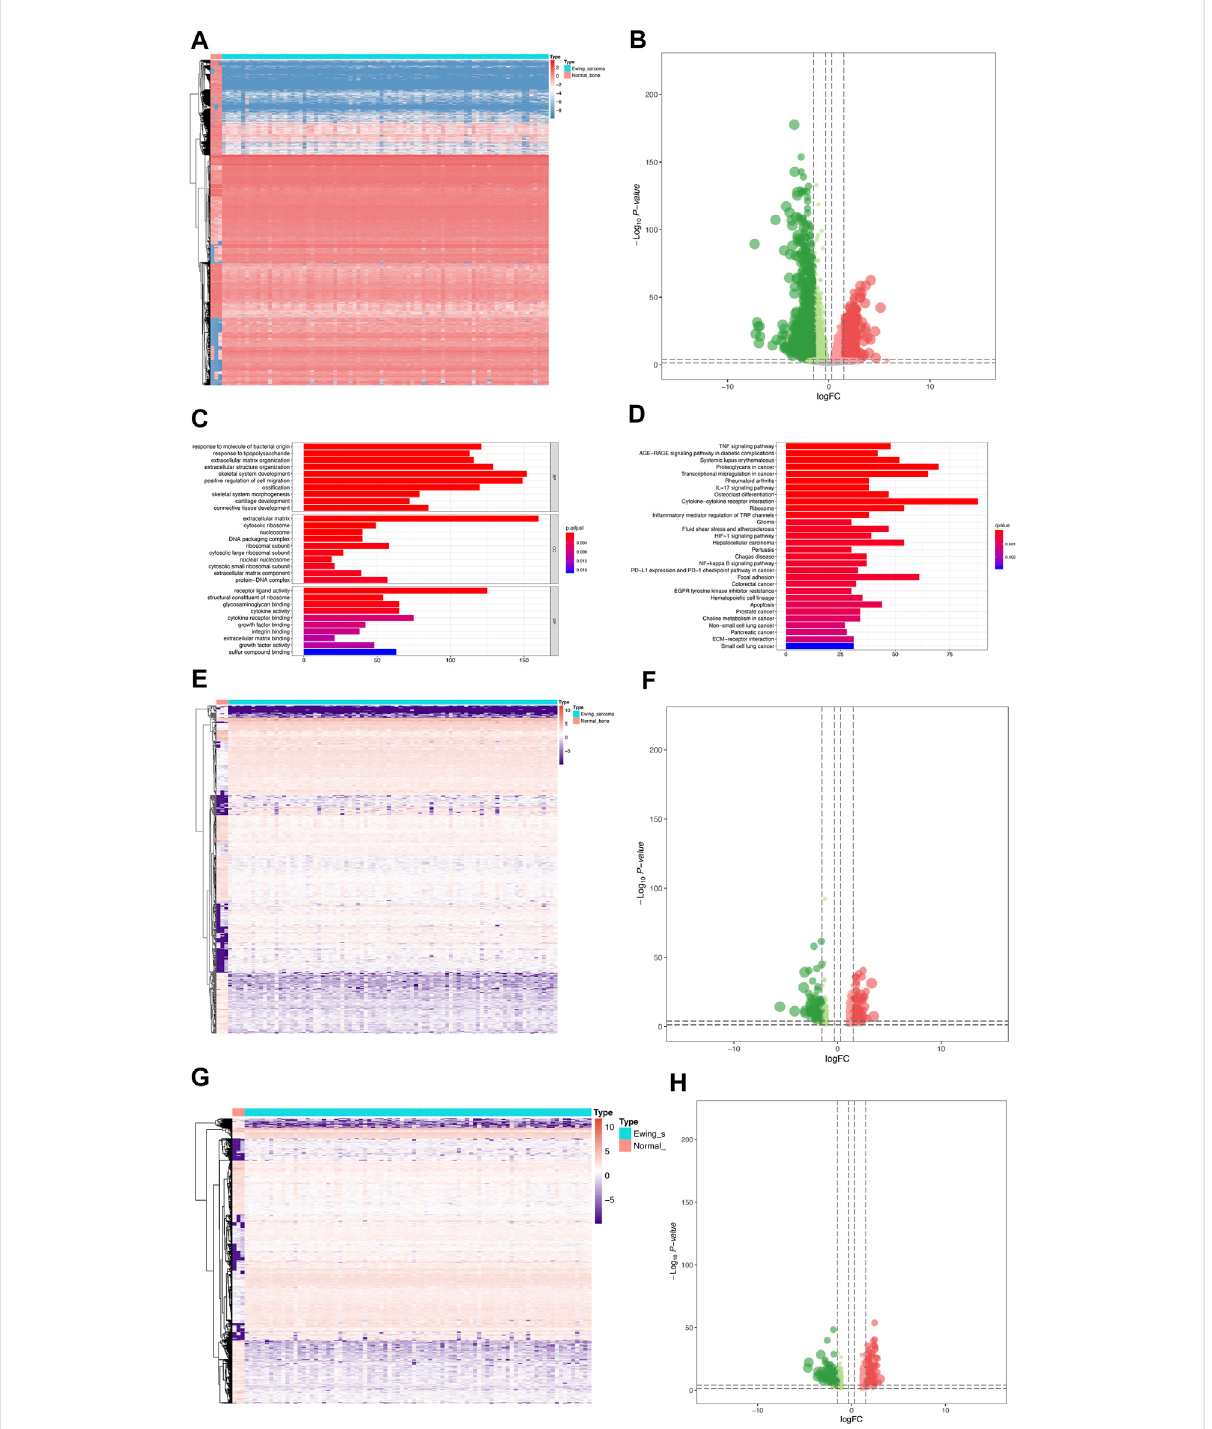
FIGURE 1 Identi fi cation of DEGs, DEeRNAs, and DETFs. (A) The DEG analysis between 85 Ewing sarcoma patients and 3 normal samples. (B) The volcano plotofatotalof4,941DEGsidenti fi edbetweenEwingsarcomasamplesandnormalsamples. (C) TheGOenrichmentanalysisofDEGs. (D) TheKEGG enrichment analysis of DEGs. (E) The heatmap of 669 DEeRNAs identi fi ed between Ewing sarcoma samples and normal bone samples. (F) The volcanoplotofDEeRNAs. (G) Theheatmapof664DETFsidenti fi edbetweenEwingsarcomasamplesandnormalbonesamples. (H) Thevolcano plot of